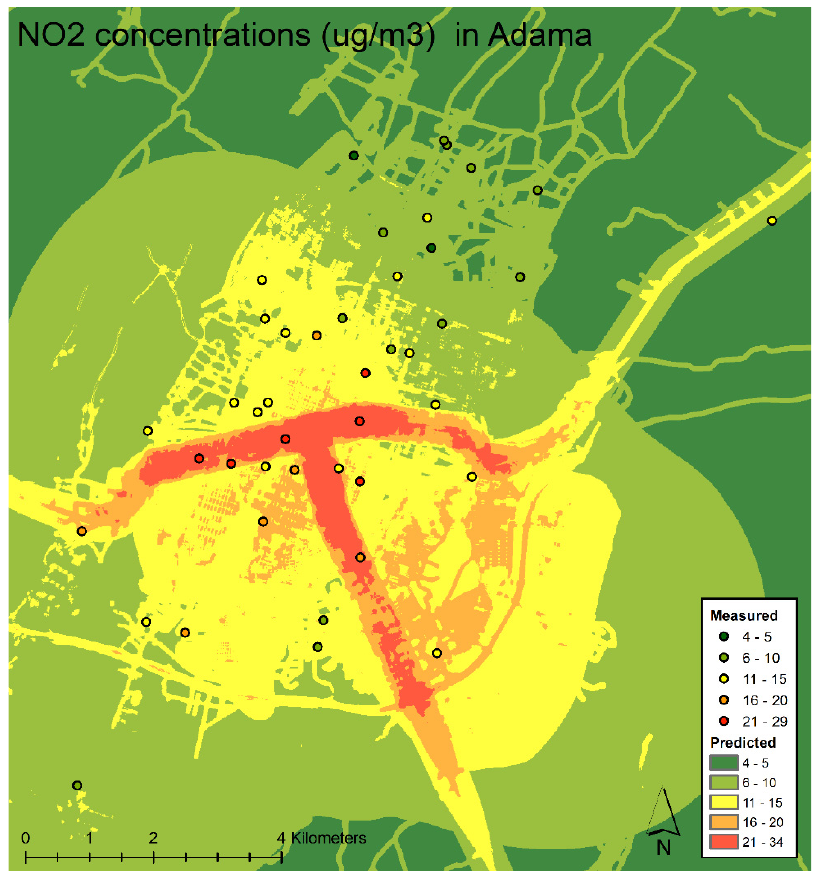
Figure 5. Prediction map of the NO 2 concentrations in a 10-m grid over Adama based on the developed LUR model. The measured levels of NO 2 are presented by dots.